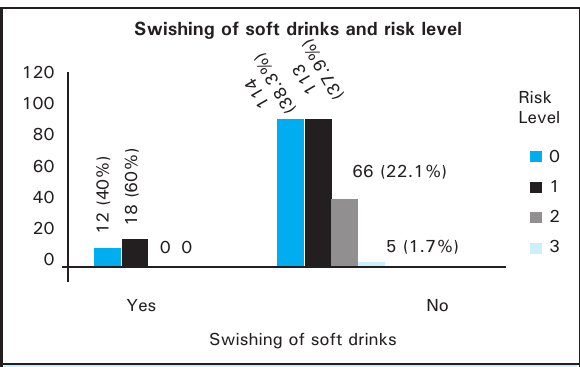
Figure 1. Association between tooth wear and swishing of soft